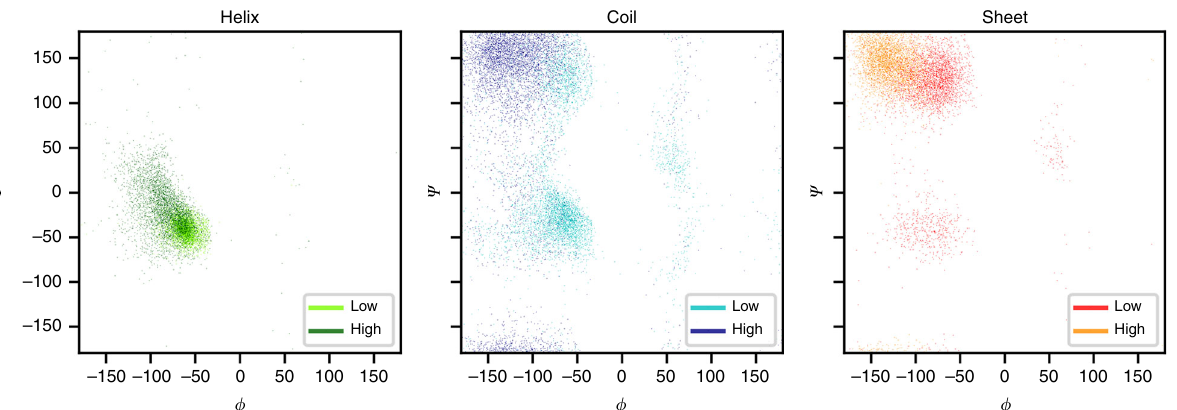
Fig. 2 Torsion angles distribution for extreme ShiftCrypt values. Torsion angles distribution for low (dark) and high (light) values of ShiftCrypt, strati fi ed by secondary structure. Only the residues for which the same secondary structure is assigned to the residue in question in all the NMR models are taken into consideration